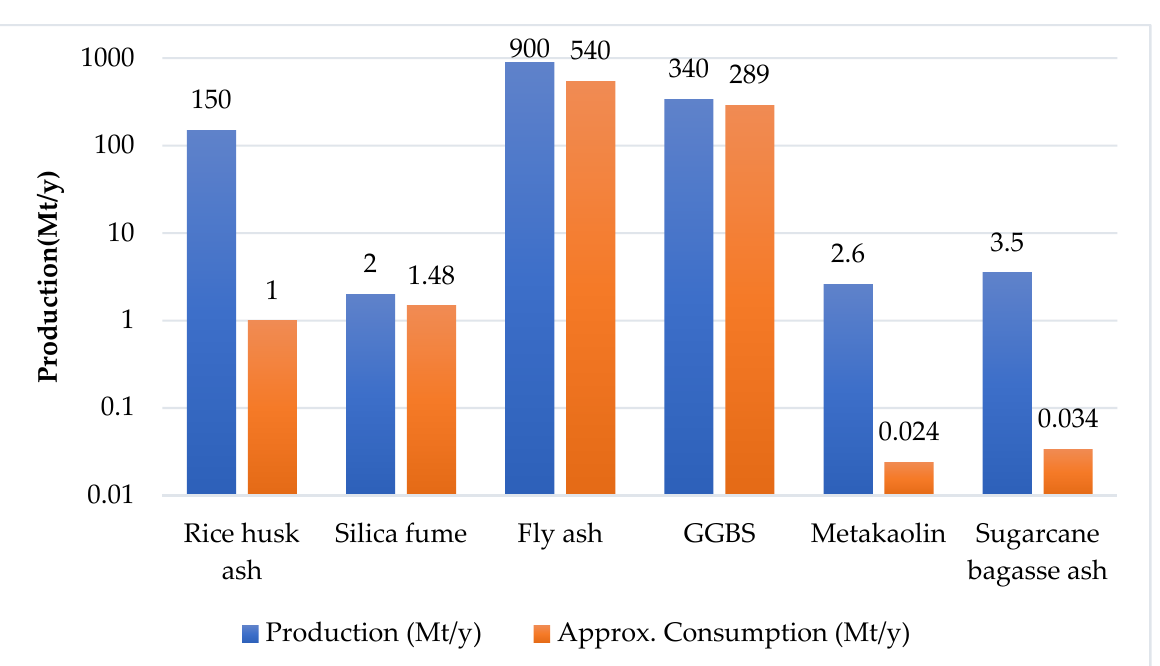
Figure 2. Production and consumption of different precursors [32].